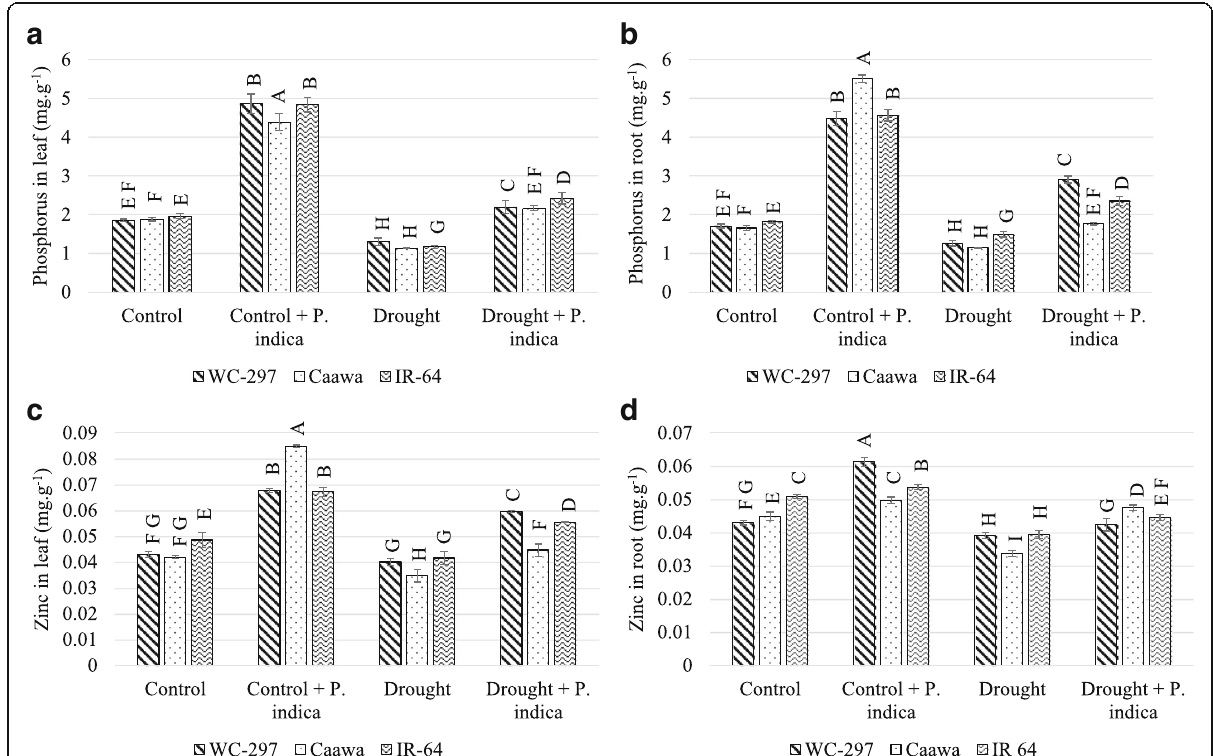
Fig. 3 Phosphorus and zinc concentration in rice leaf and root. The inoculation with P. indica increased the level of P and Zn in leaf and root. a Increase in the concentration of P in leaves. b P concentration in roots. c Zn concentration in leaves. d Zn concentration in roots. Alphabetic on the top of each bar are showing the LSD 0.05